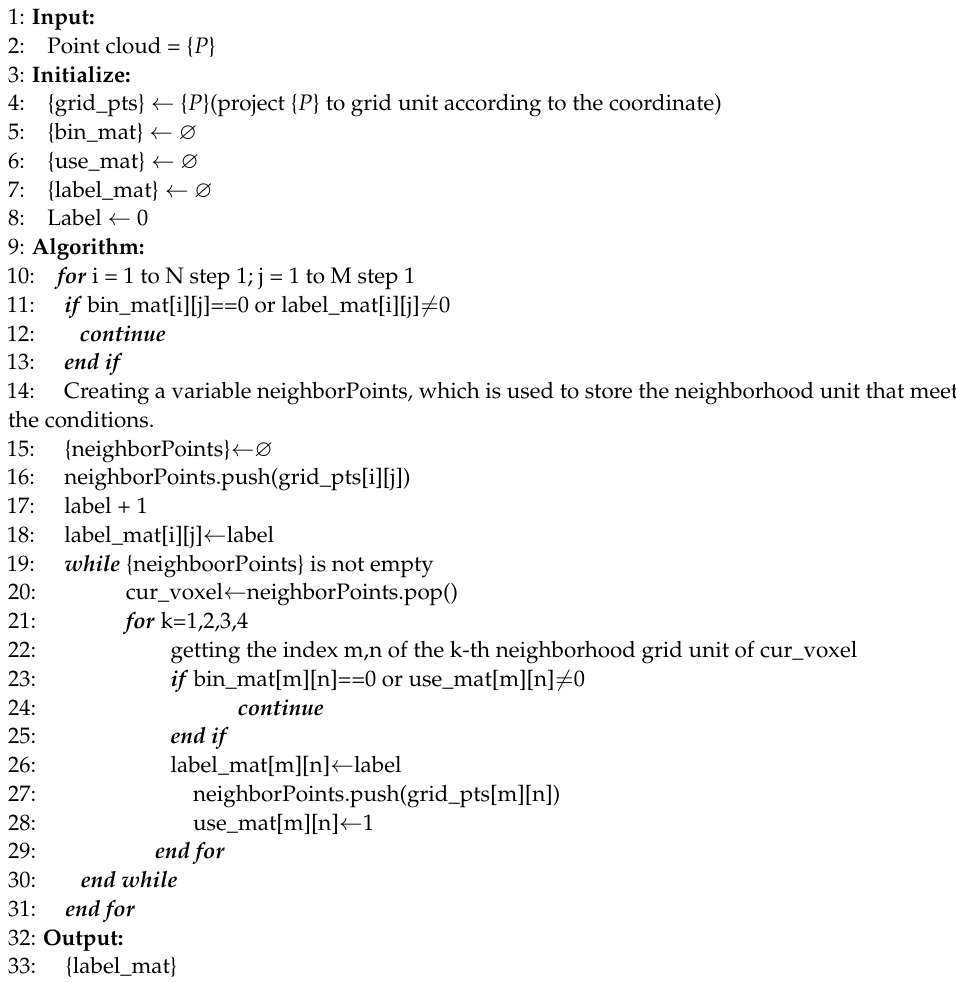
Algorithm 1. Regional growth clustering based on grid